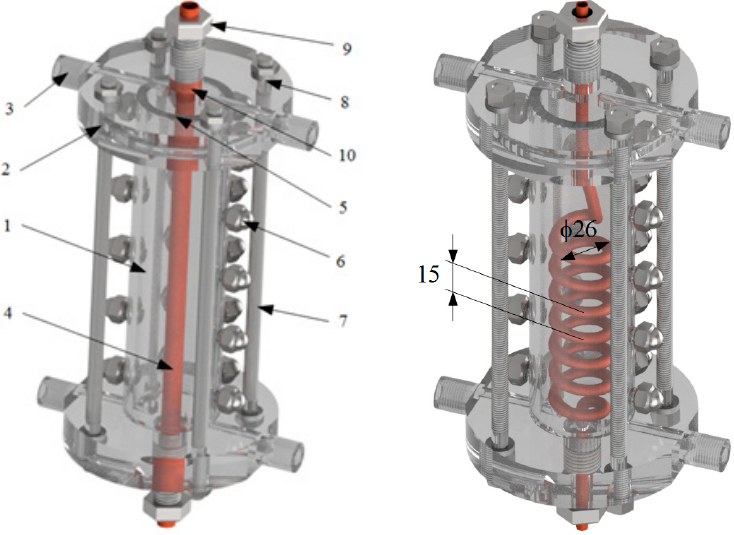
Figure 6. View of the experimental module, at left-with straight working element, at right with coil working element: 1—jacket; 2—flanges; 3—stubs; 4—replaceable working element; 5—rubber gasket; 6—temperature sensors glands; 7—threaded steel rods; 8—rubber pads; 9—working element glands; 10—gasket.